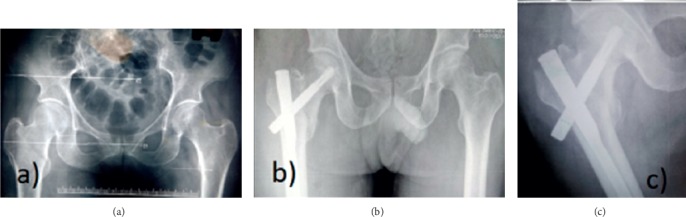
(a) Preoperative X-ray. (b) Immediate postoperative X-ray of PFNA-2 with lateral entry point showing lateral cortex impingement with gap at fracture site. (c) Follow-up at 6 months. Fracture union was seen at 6 months but with screw back out.